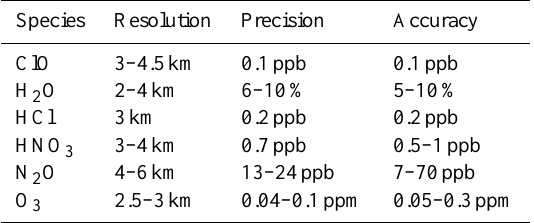
Table 4. Altitude resolution and errors of the species measured by MLS. Typical values between 100hPa and 10hPa (Livesey et al.,